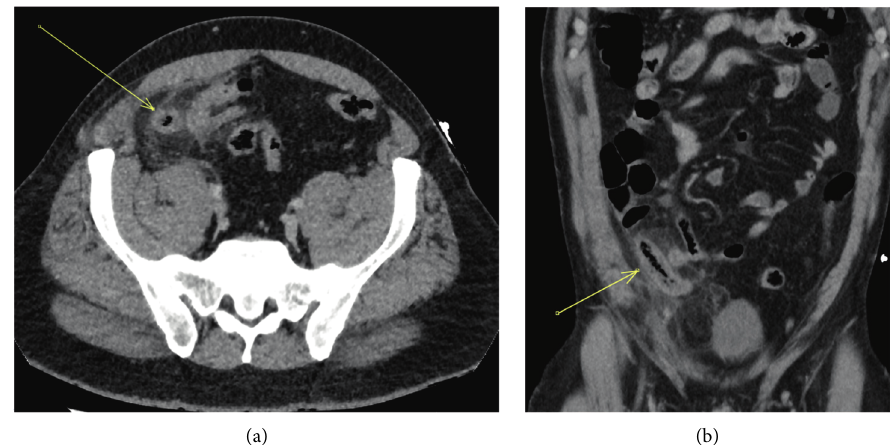
Figure 3: A 45-year-old man with appendiceal intraluminal gas (arrow) on noncontrast CT in axial (a) and coronal (b) projections. Histological and surgical evidence of gangrenous appendicitis. Note the distended appendix with a thickened wall and surrounding fat stranding.